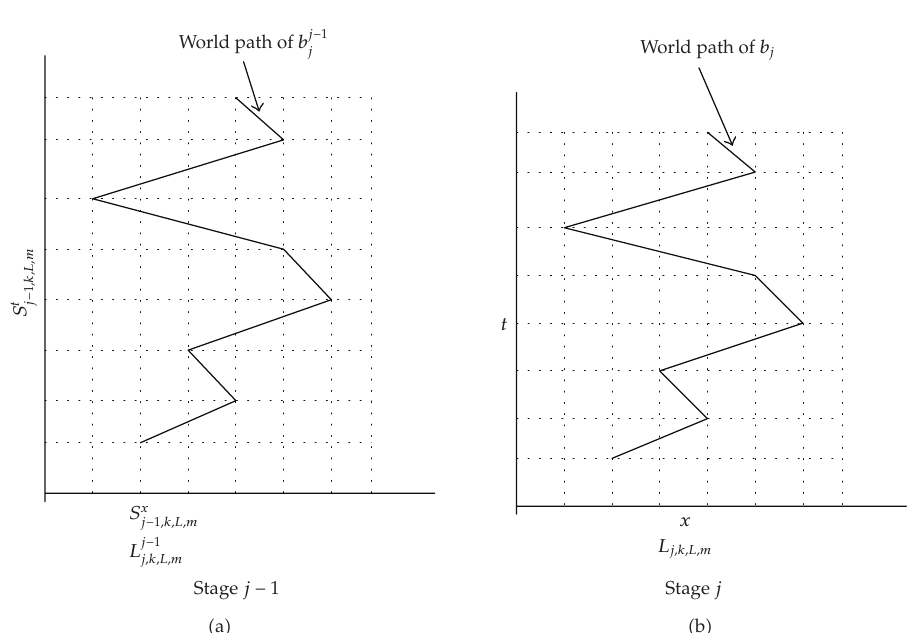
Figure 2: Stage j and stage j − 1 images of one-dimensional space and time lattices. Lattice points are indicated by intersections of lines in the two-dimensional grid. In L j,k,L,m the points p j consist of pairs − 1 − 1 of rational numbers. In L j the image points p j consist of pairs S x ,S t of hybrid systems j j − 1 ,k,L,m j,k,L,m j − 1 ,k,L,m with point locations given by the states of the system pairs. Nonrelativistic world paths of a stage j physical − 1 system b j and of its stage j − 1 image b j are shown as solid lines. Note that b can also be a hybrid j